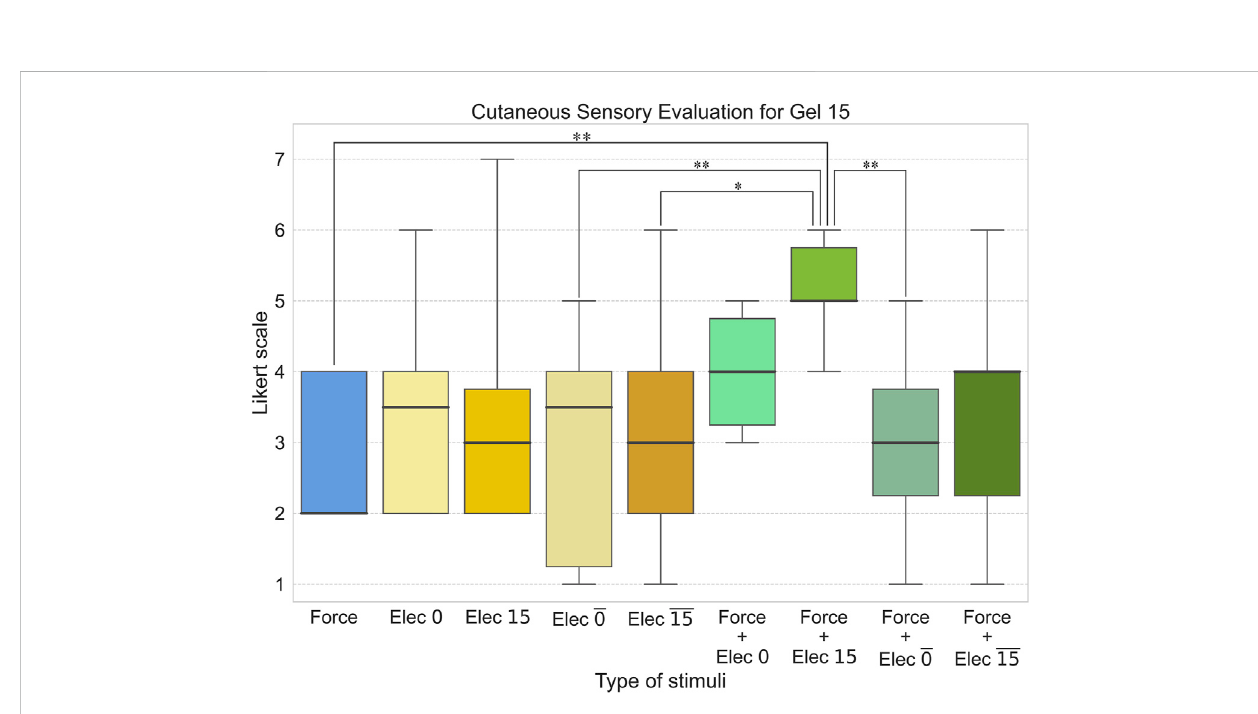
Subjective evaluation of cutaneous sensation for Gel 15 (*: p < 0.05, **: p <